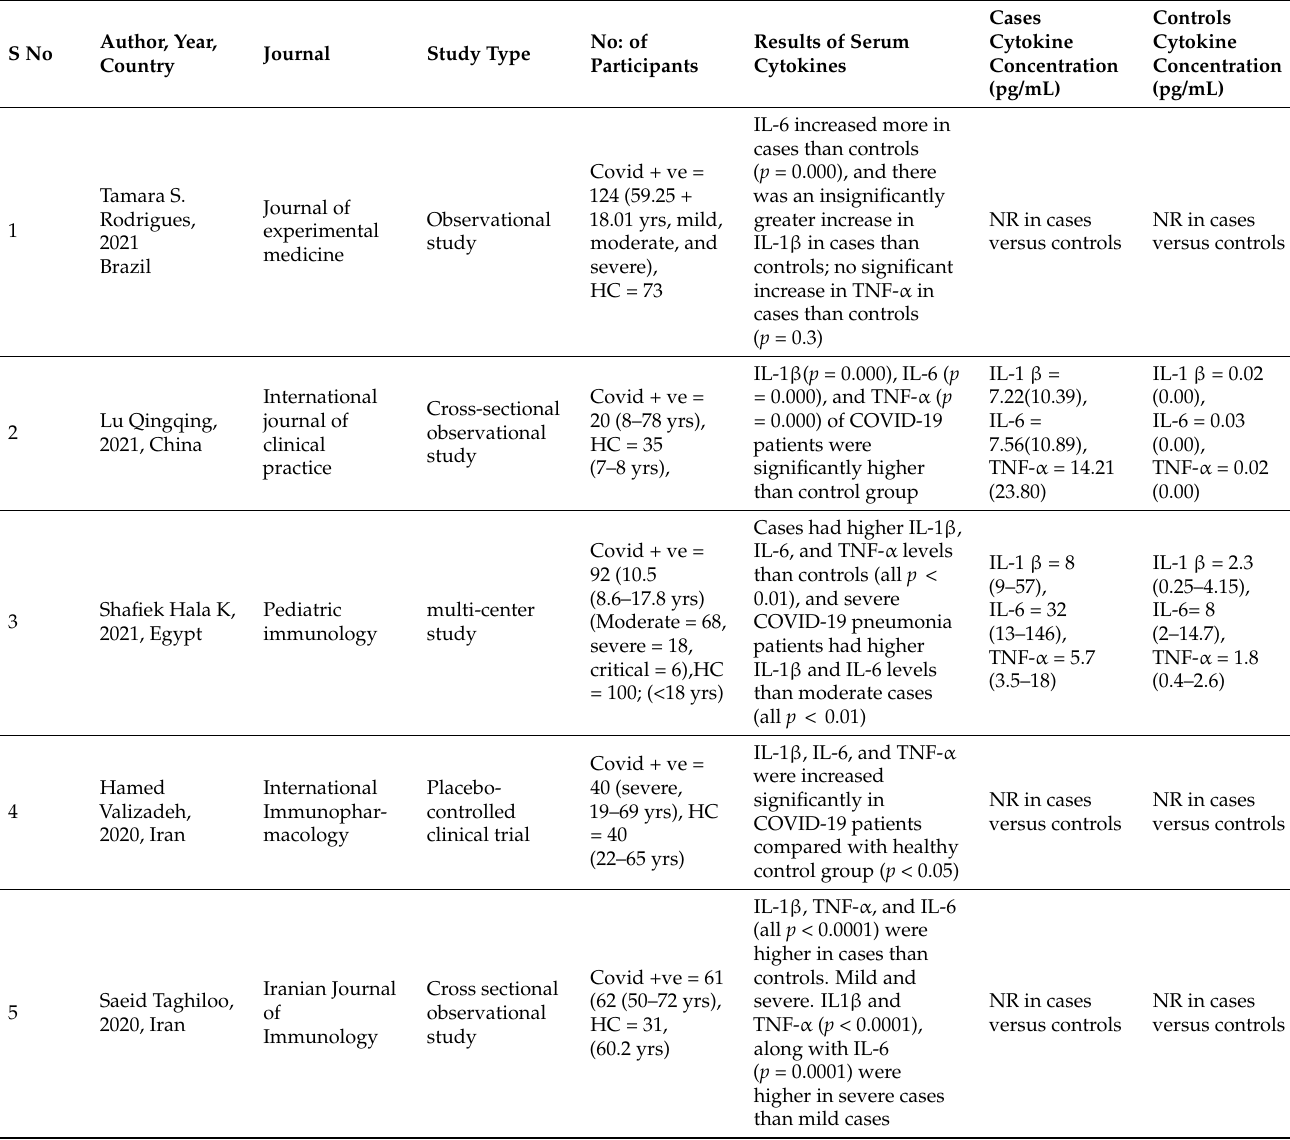
Table 2. Data collected from included studies from the COVID-19 search